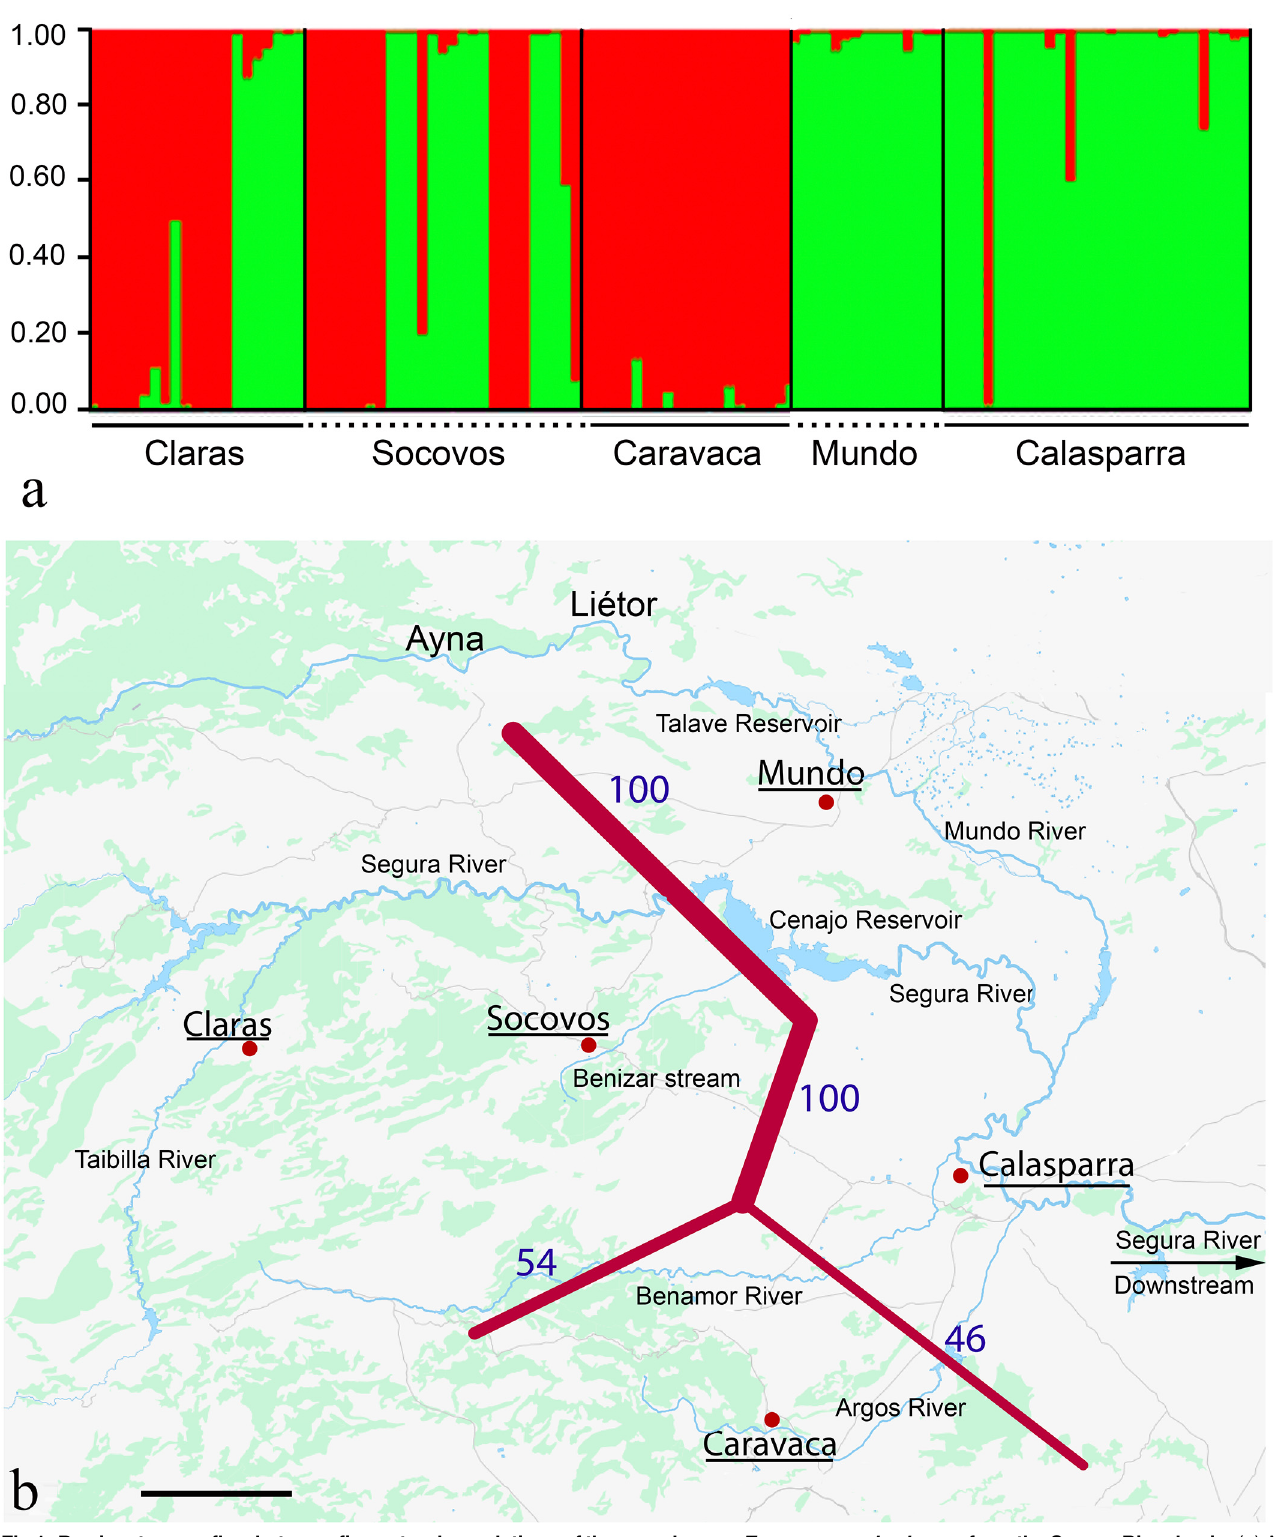
Fig 1. Barriers to gene flow between five natural populations of the grasshopper Eyprepocnemis plorans from the Segura River basin. (a) Ancestry of each individual to any of the two groups yielded by the Structure software, using ISSR markers. Note that most individuals from the B-lacking populations